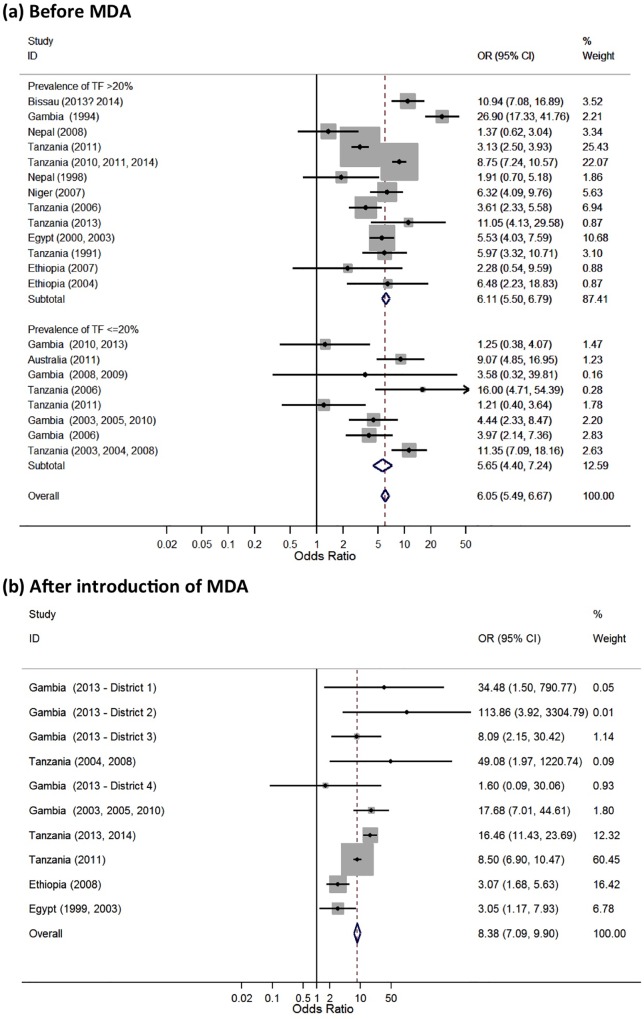
A Forest plot showing the relationship between Active Trachoma (TF or TF/TI) and the detection of C. trachomatis infection at the individual level (a) before and (b) after the introduction of MDA, grouped by community TF prevalence level. Studies are ordered by increasing prevalence of TF, the size of the grey boxes represent the how much weight each study contributes to the overall estimate, the blue diamonds represent the subtotal and overall pooled odds ratio estimates. The odds ratios are for ocular C. trachomatis infection as the outcome and TF as the explanatory variable.